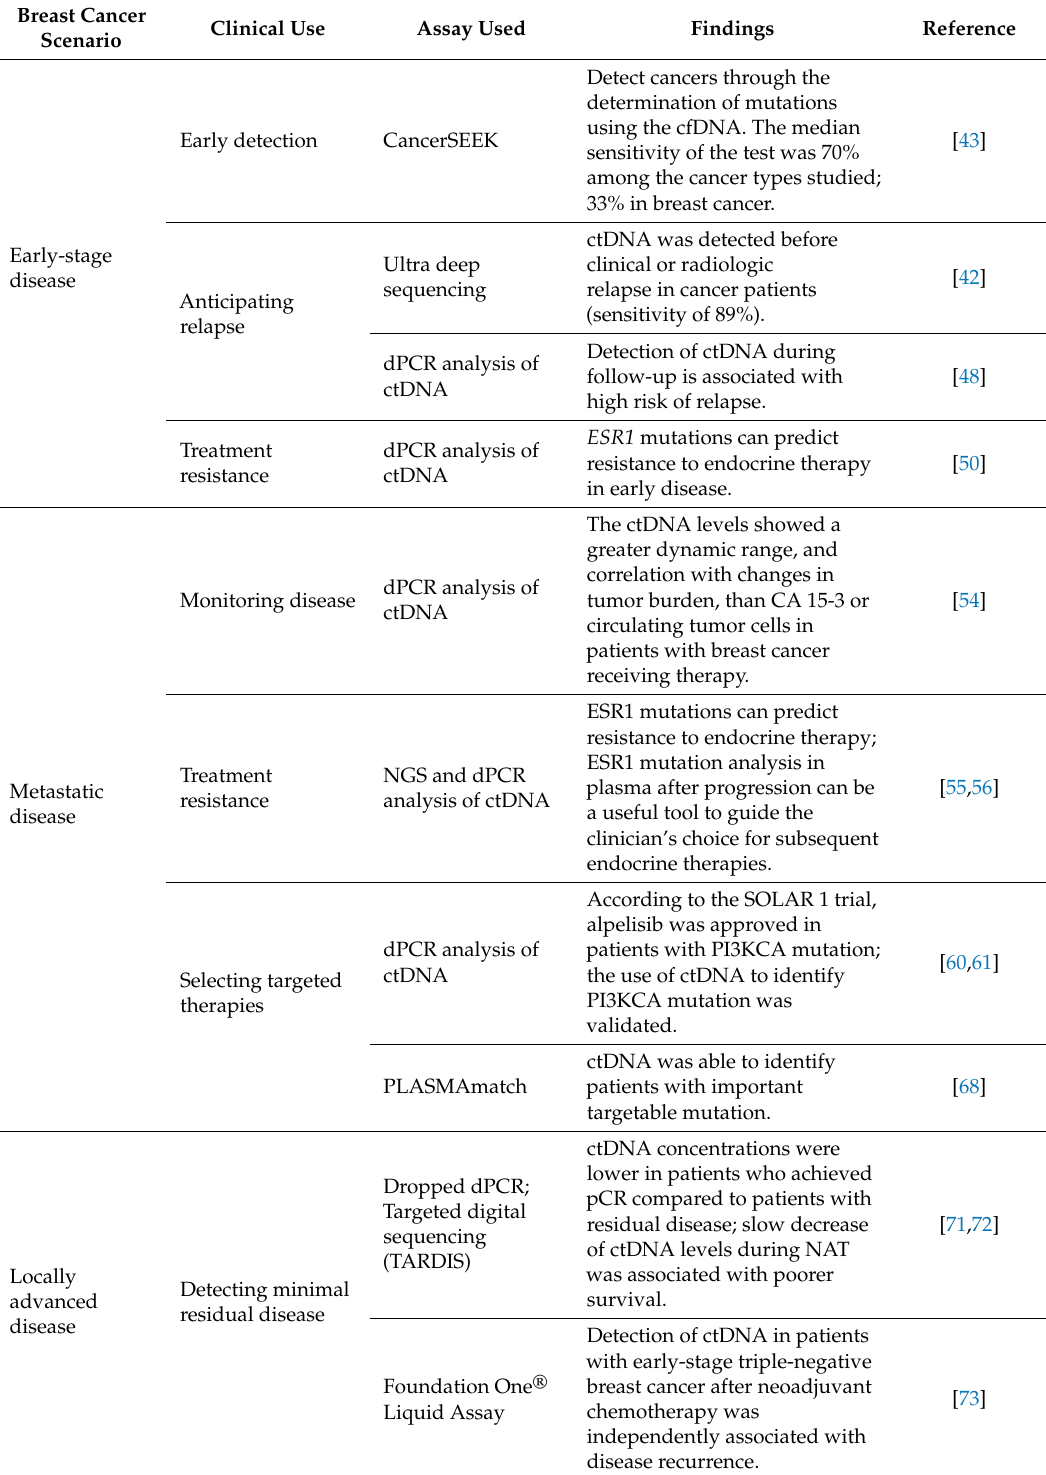
Table 2. Clinical utility of using ctDNA in di ff erent breast cancer